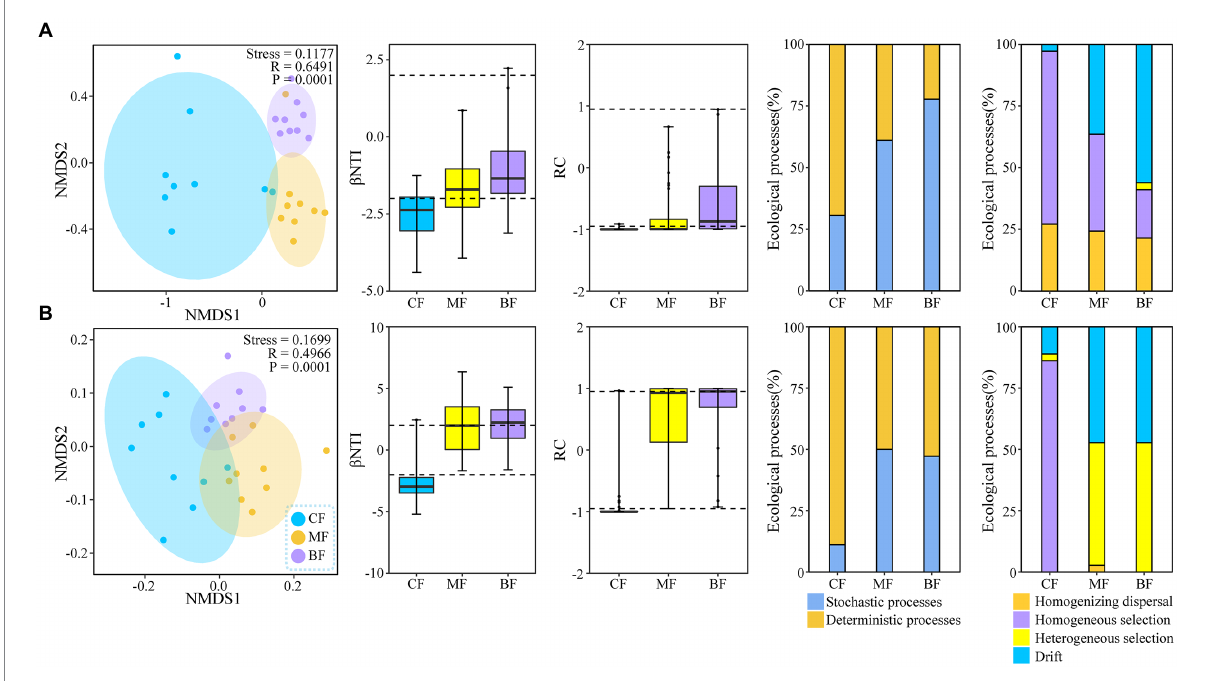
FIGURE 3 Non-metric multidimensional scaling ordination based on Bray-Curtis similarities and the ecological processes governing the compositional variation of soil bacterial (A) and fungal (B) communities under forest stand